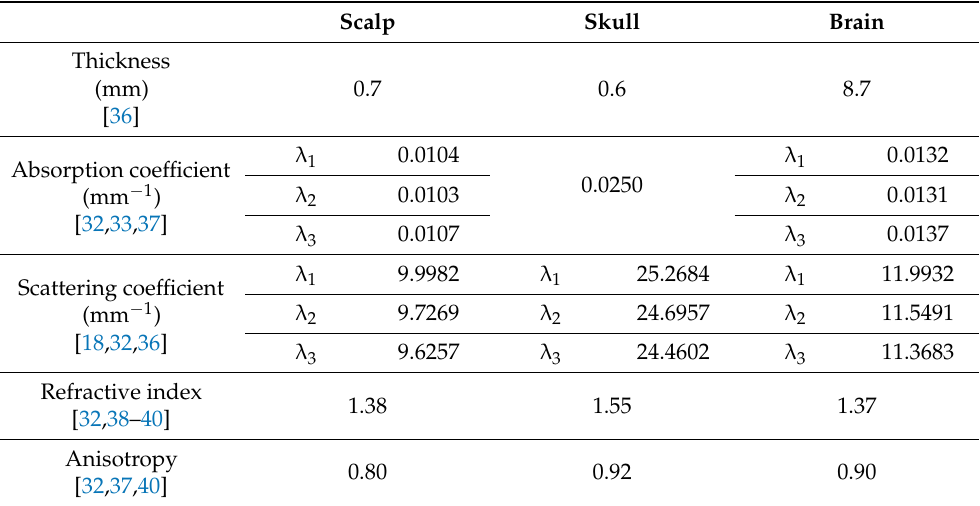
Table 1. Dimensional and optical properties used in Monte Carlo simulation. λ 1 : 780 nm; λ 2 : 808 nm; λ 3 : 820